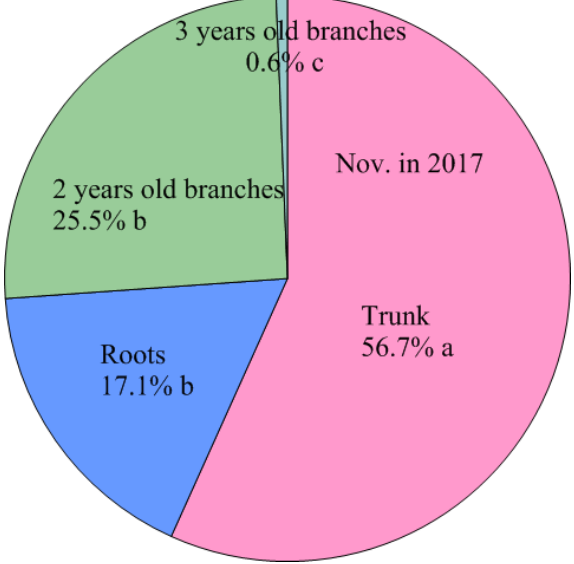
Figure 6. The distribution of N 2016 , withdrawn from senescent leaves, among various perennial structures of pear trees in autumn 2017. N 2016 means amount of fertilizer-N derived in 2016. Different small letters indicate significant differences ( p < 0.05) among organs.